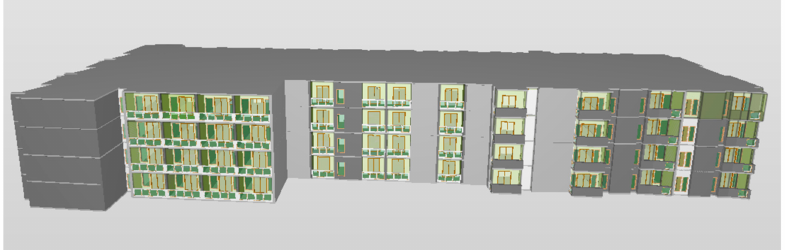
Figure 19. The IFC model of the second real dataset in Solibri AnyWhere (light green solids show legal spaces).